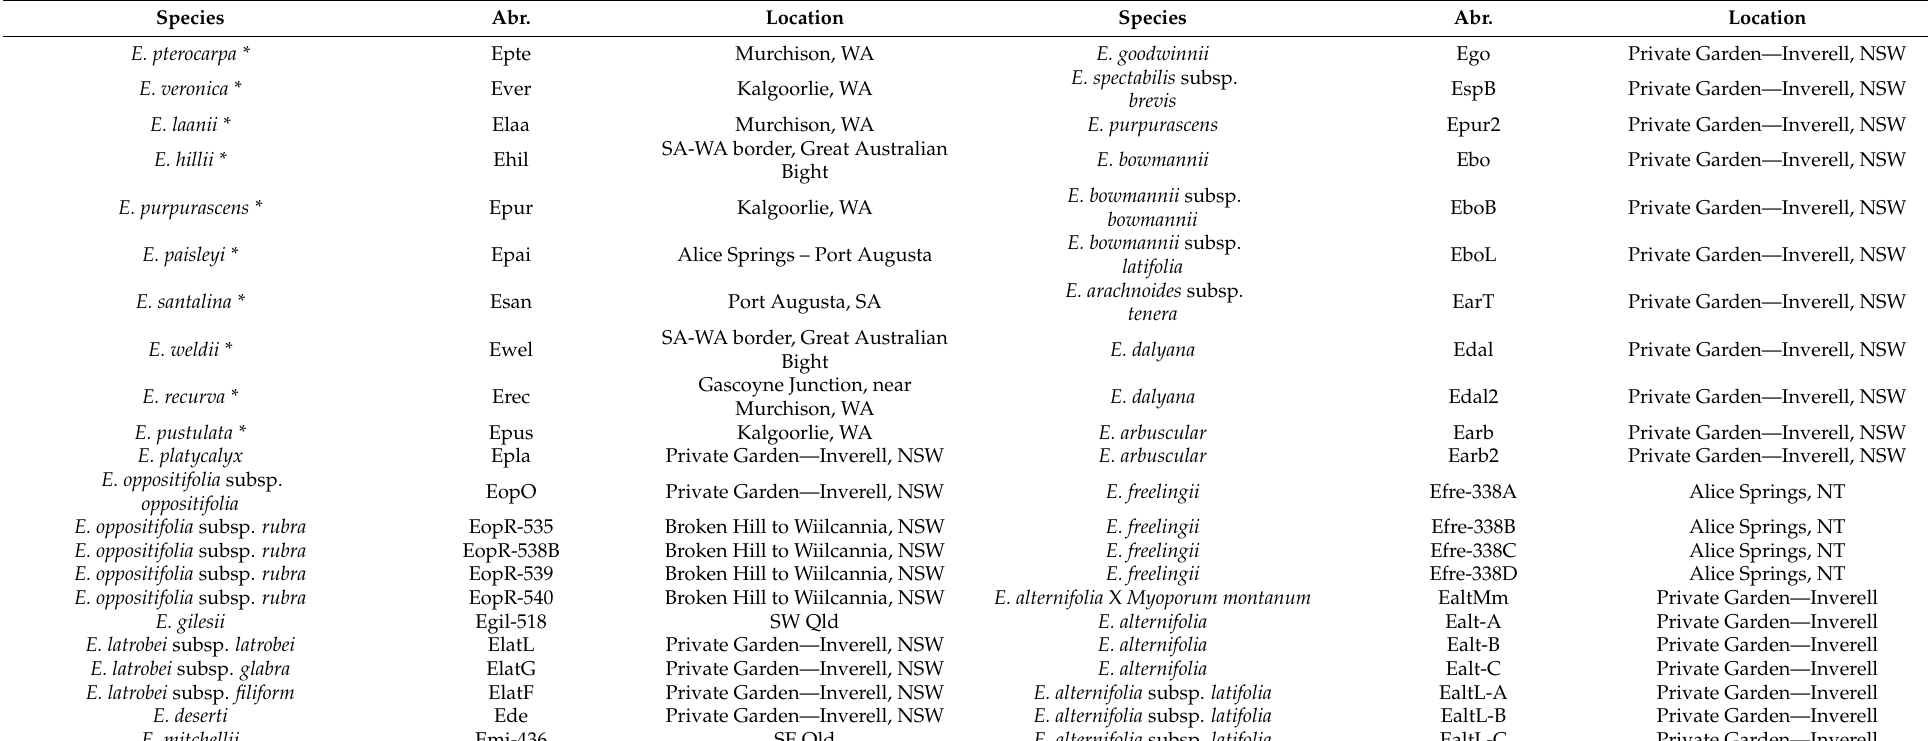
* Cultivated at Australian Arid Lands Botanic Garden of Port Augusta, South Australia. Location indicates endemic